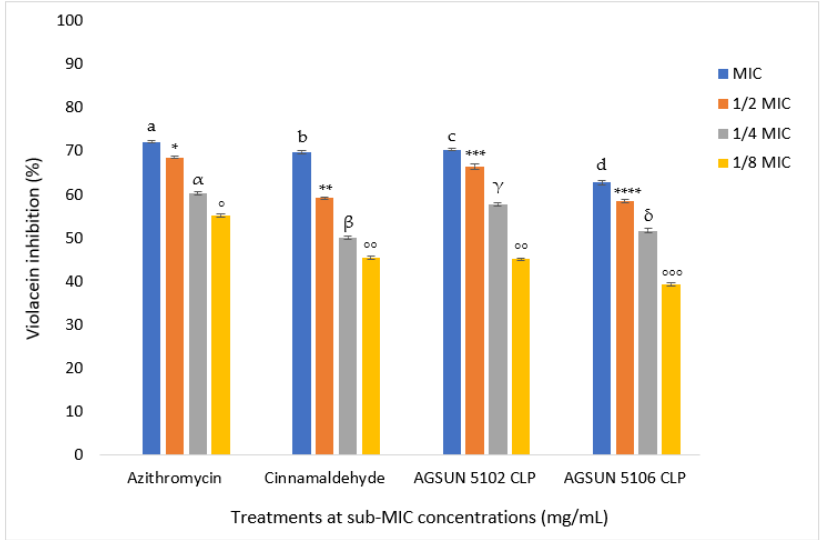
Figure 3. Inhibitory effect of the oils on the production of violacein by C. violaceum ATCC 12472 at sub-MIC concentrations (mg/mL) of azithromycin at 0.25–0.031 mg/mL (MIC to 1/8 MIC), cinnamaldehyde at 3.75–0.47 mg/mL (MIC to 1/8 MIC) and both oils (AGSUN 5102 CLP and AGSUN 5106 CLP) at 91.8–11.48 mg/mL (MIC to 1/8 MIC). Letters/symbols represent statistical differences at p - value ≤ 0.05.